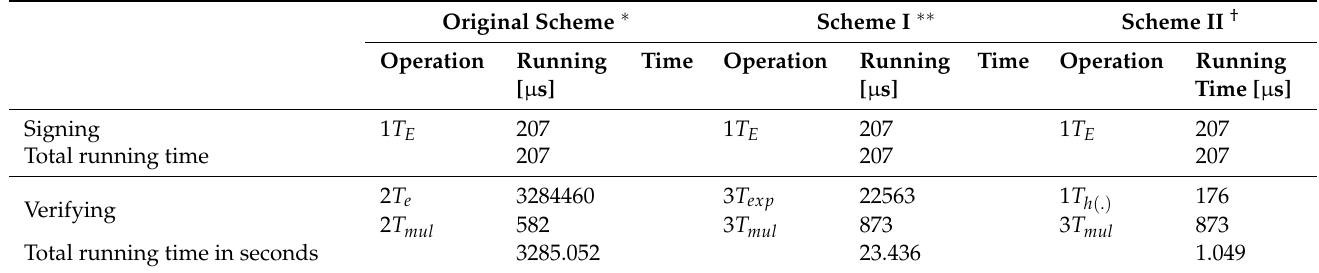
Table 4. Efficiency comparison in smartwatch platform.